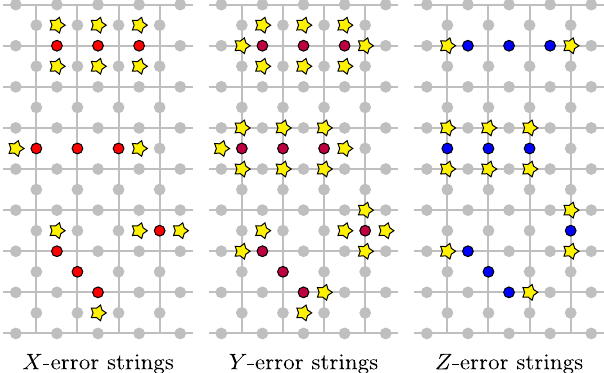
FIG. 5. A sample of X -, Y -, and Z -error strings, indicated by colored circles, with corresponding anticommuting syndrome locations, indicated by yellow